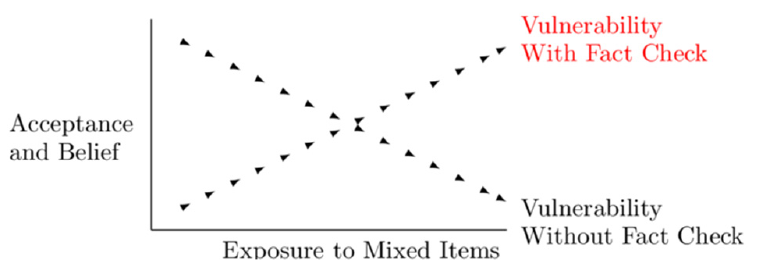
Figure 1. As blind belief falls on exposure, vulnerability decreases; vice versa with reliance on fact Figure 1. Asblindbelieffallsonexposure, vulnerabilitydecreases; checking.